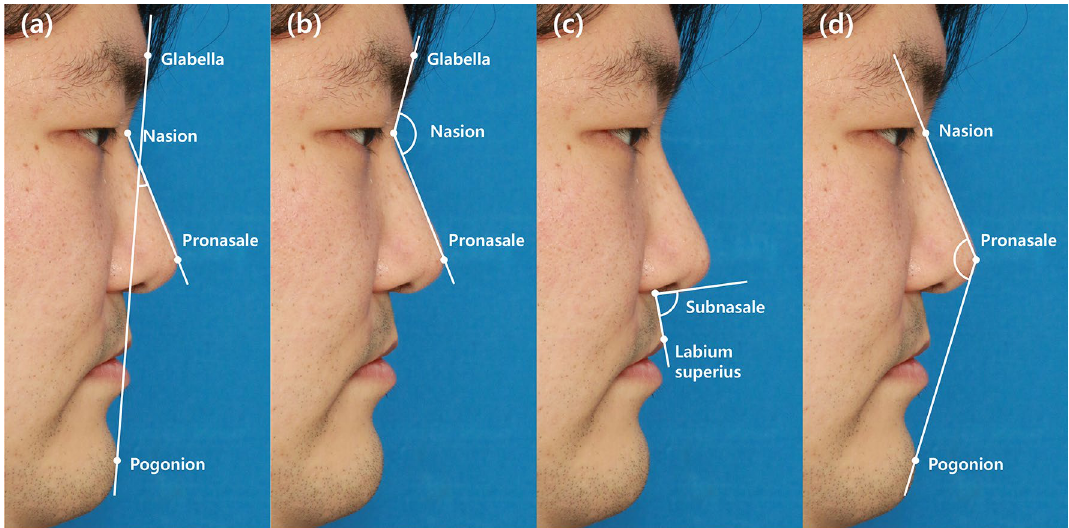
Figure 2. Landmarks on lateral view of 2D photograph. Four angular components were derived as follows. ( a ) Nasofacial angle: nasion-pronasale line intersecting with glabella-pogonion line. ( b ) Nasofrontal angle: glabella- nasion-pronasale. ( c ) Nasolabial angle: subnasale-columella line intersecting with subnasale-labium superius line. ( d ) Nasomental angle: